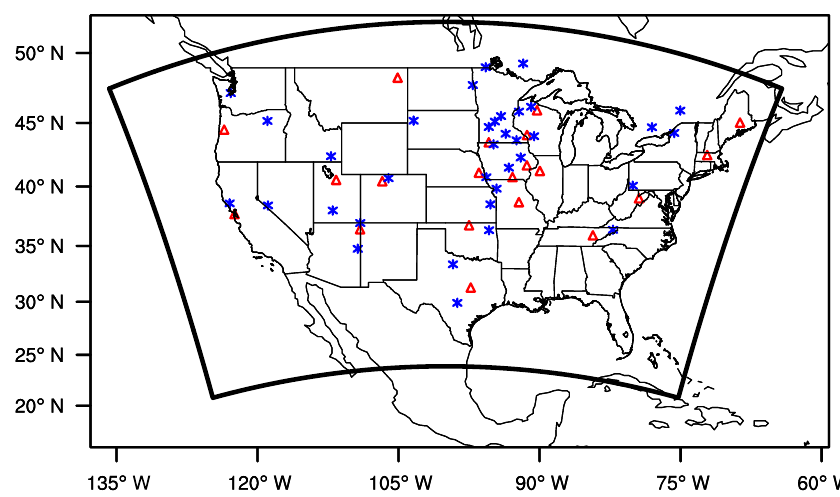
Figure 3. WRF 4D-Var simulation domain covering the continental United States with 48km × 48km grid spacing. The domain boundary is marked by the bold dark outline. Grid cells used for evaluating sensitivities are marked: red triangles are the 20 CO 2 tower sites used as receptor locations; blue stars are source locations. While receptors are placed at the first, fifth, and tenth vertical levels at each site; all sources are at the first level only.